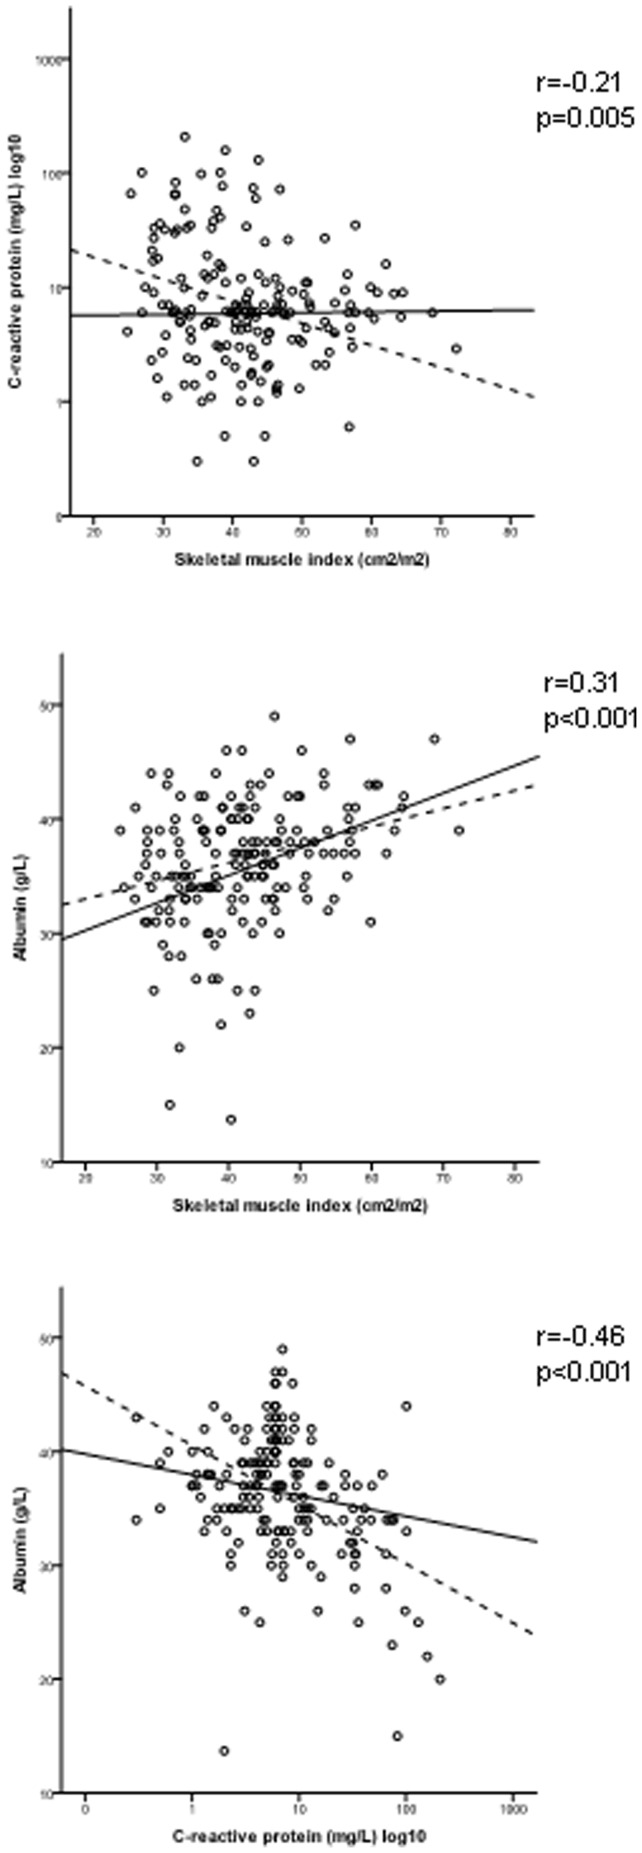
Scatterplots of the associations between C-reactive protein, albumin and skeletal muscle index.Fit lines are shown for male (____) and female (––-) patients. r = Pearsons correlation coefficient for all patients.